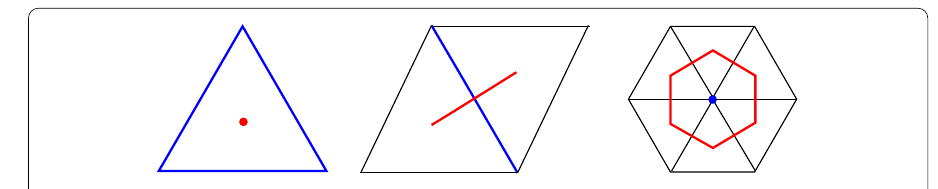
Fig. 29 Examples of primal simplices (in blue) and their duals (in red)